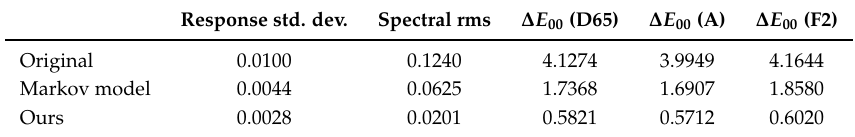
Table 6. Comparison with the Markov model [10] on measurement consistency. Average standard deviations of camera responses, spectral rms errors, and color difference errors of the test data are